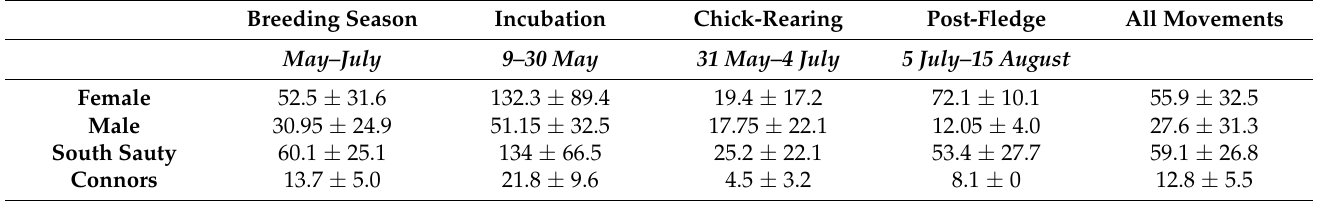
Table 2. Means and standard deviation (SD) of 95% home range (km 2 ) of Double-crested Cormorants on Guntersville Reservoir for female, male, and colony affiliation by breeding periods (in bold first column and top